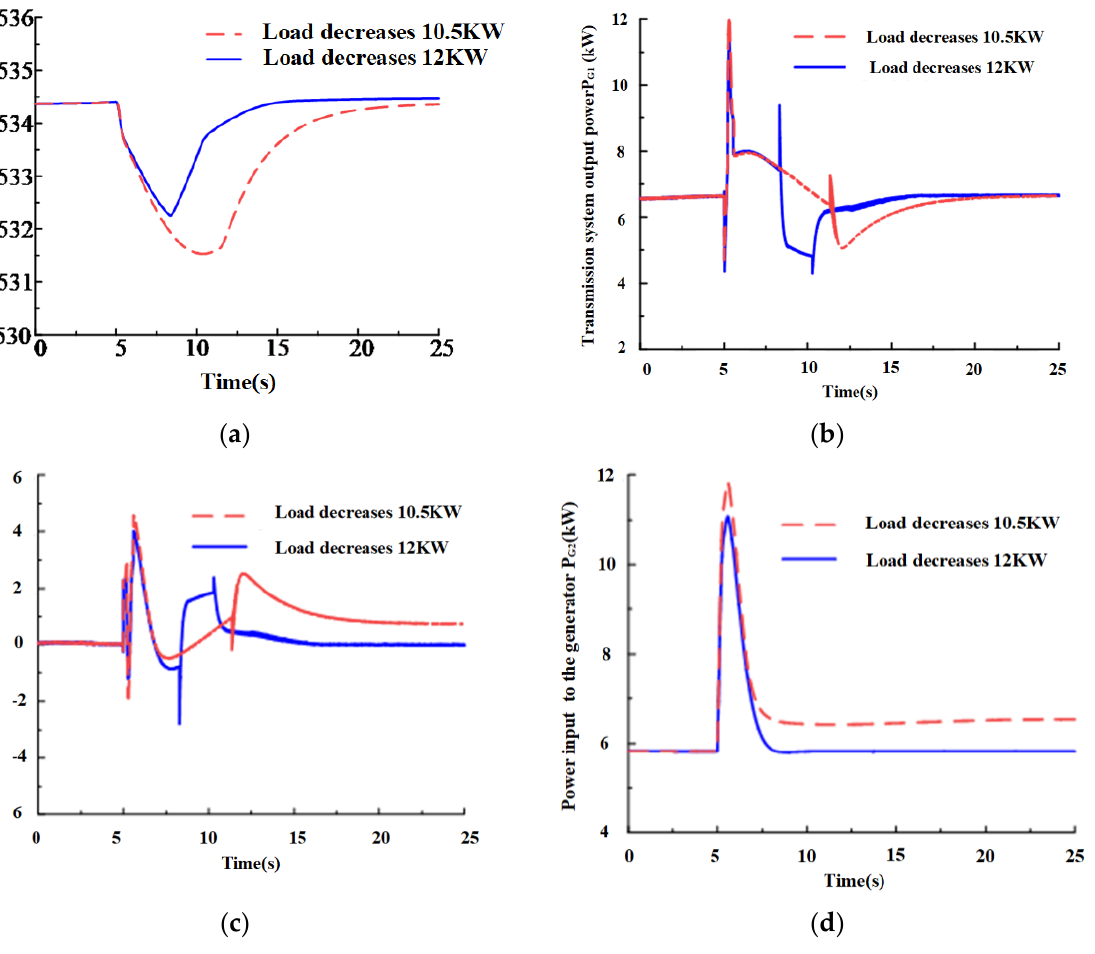
Figure 17. Rotor combined with energy storage frequency modulation simulation response curve. ( a ) The rotor-speed response curve. ( b ) Transmission power output curve. ( c ) Accumulator power output curve. ( d ) Power input to generator curve.